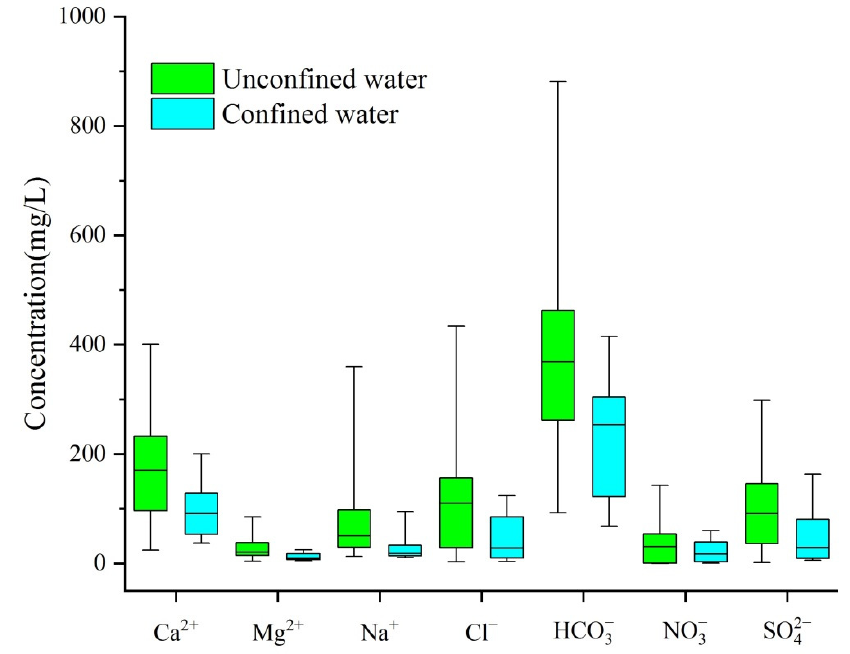
Figure 6. Box diagram of 7 main ion concentrations in confined water and unconfined water.